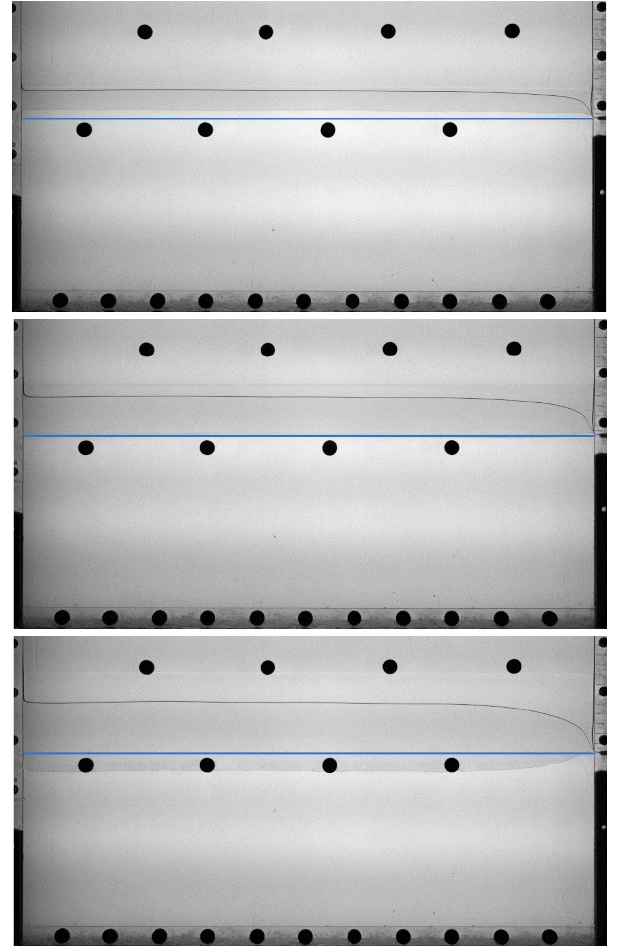
Figure 10. Interface levels at the termination of drainage for abnormal drainage (top panel), transitional drainage (middle panel), and normal drainage (bottom panel) in three experiments with an initial l–l interface level of 10 mm, a pressure drop of 0.3 bar, and oil viscosity of 0.131 Pa · s. The initial oil layer thicknesses are 20 mm, 40 mm, and 70 mm (top to bottom panels).